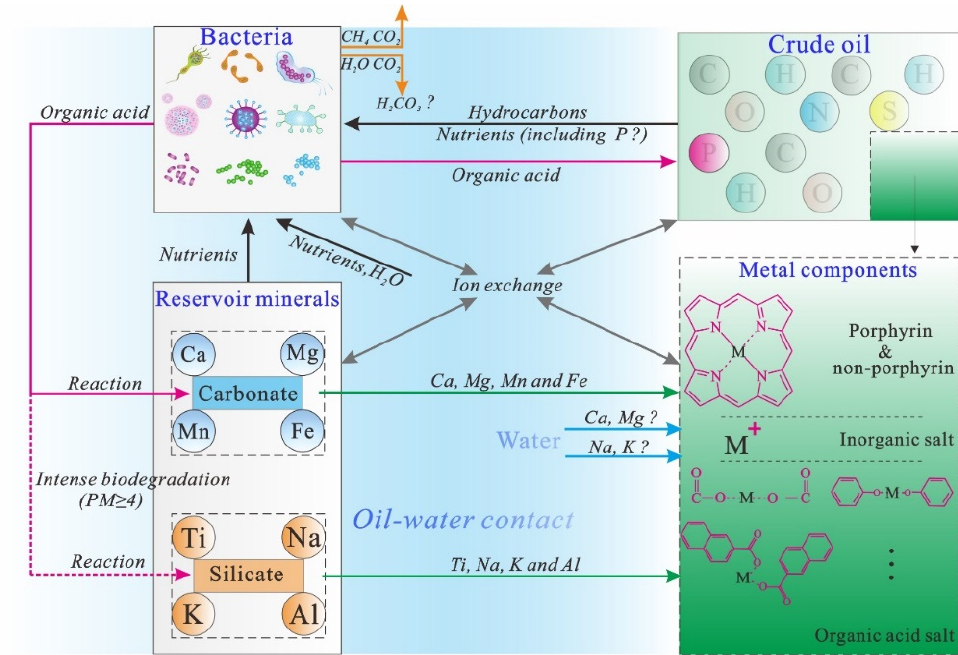
Figure 16. A model showing the possible enrichment mechanism of major elements in oil during the biodegradation process.